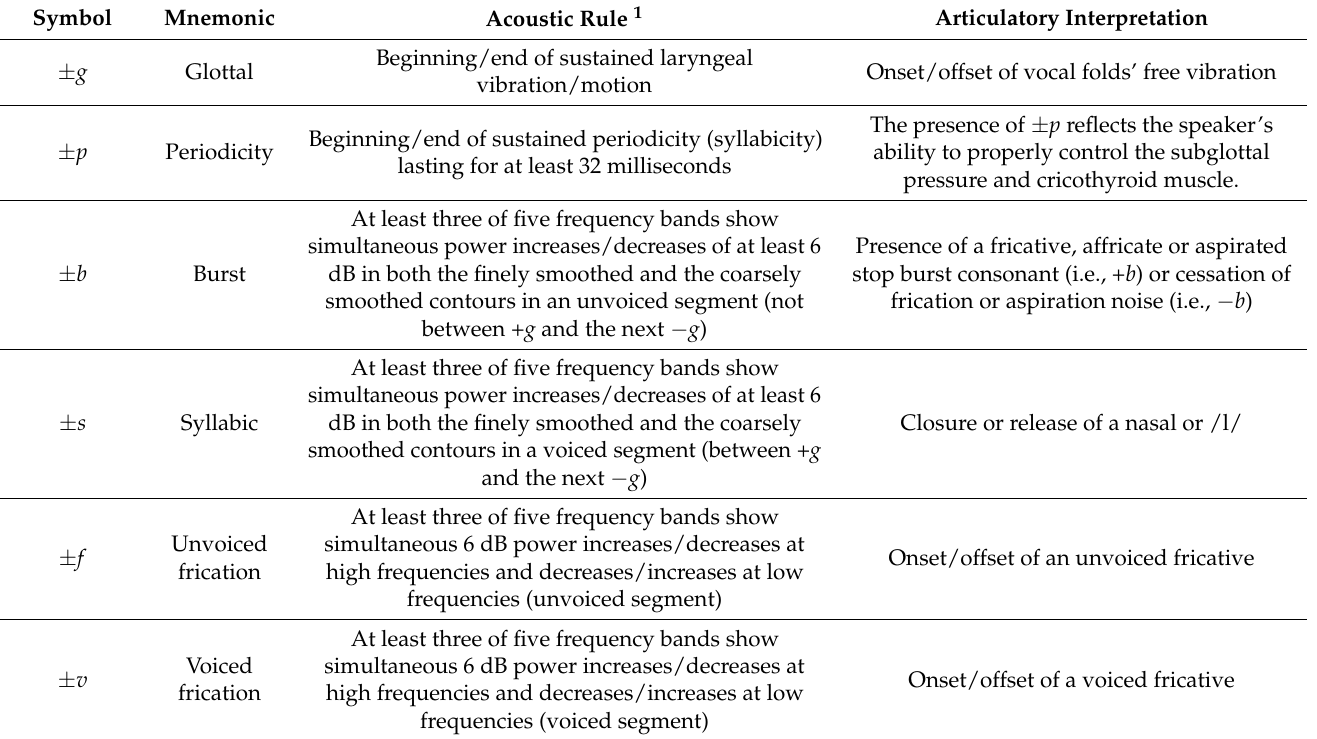
Table 1. Acoustic rules and articulatory interpretations of the six abrupt-consonantal